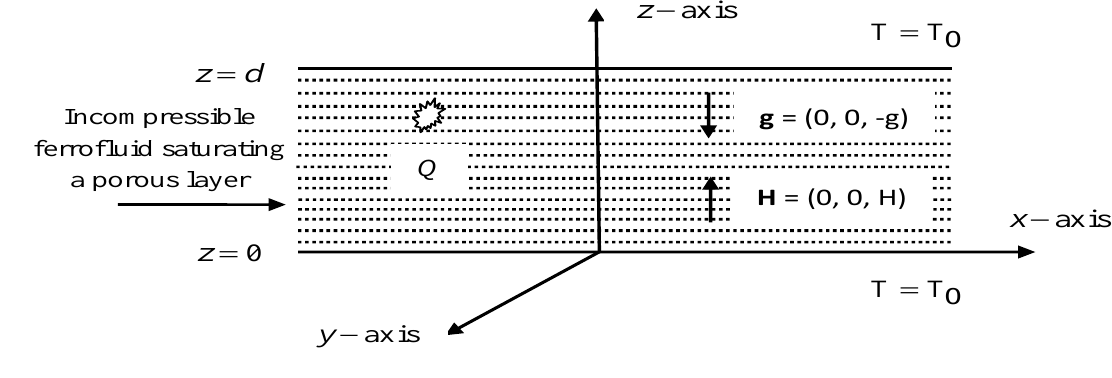
Figure 1. Geometric configuration of the